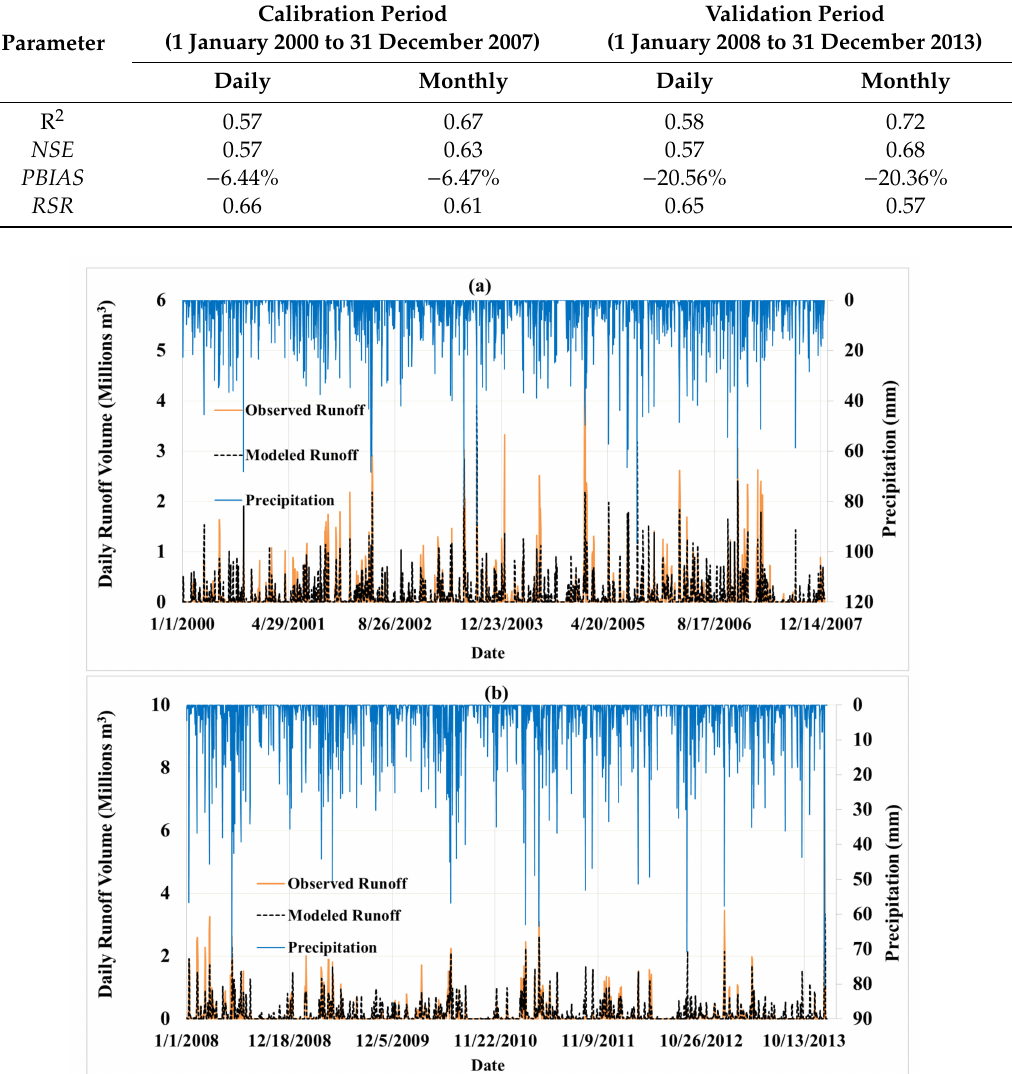
Figure 2. Graphical comparison between daily modeled and observed runo ff ( a ) after calibration and ( b ) validation phase for Sugar Creek